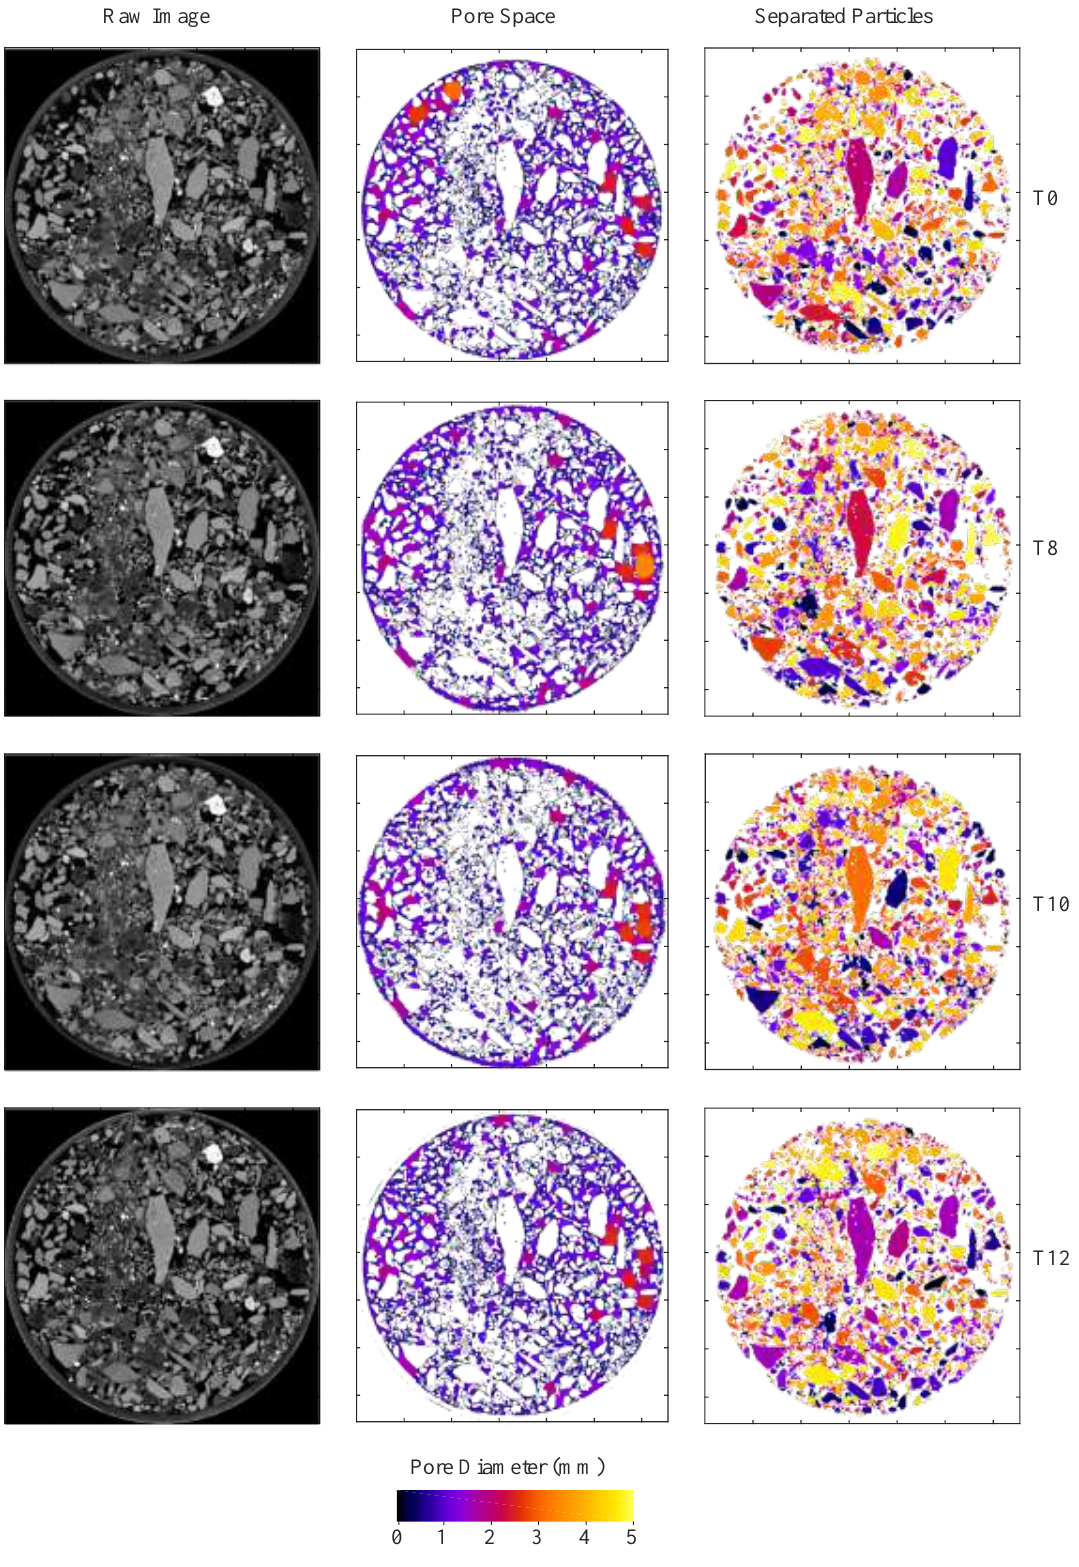
Figure 6. Example slices of unprocessed and processed XMT images for the BBS-Sedum substrate microcosms. All images are 52.4 mm across.